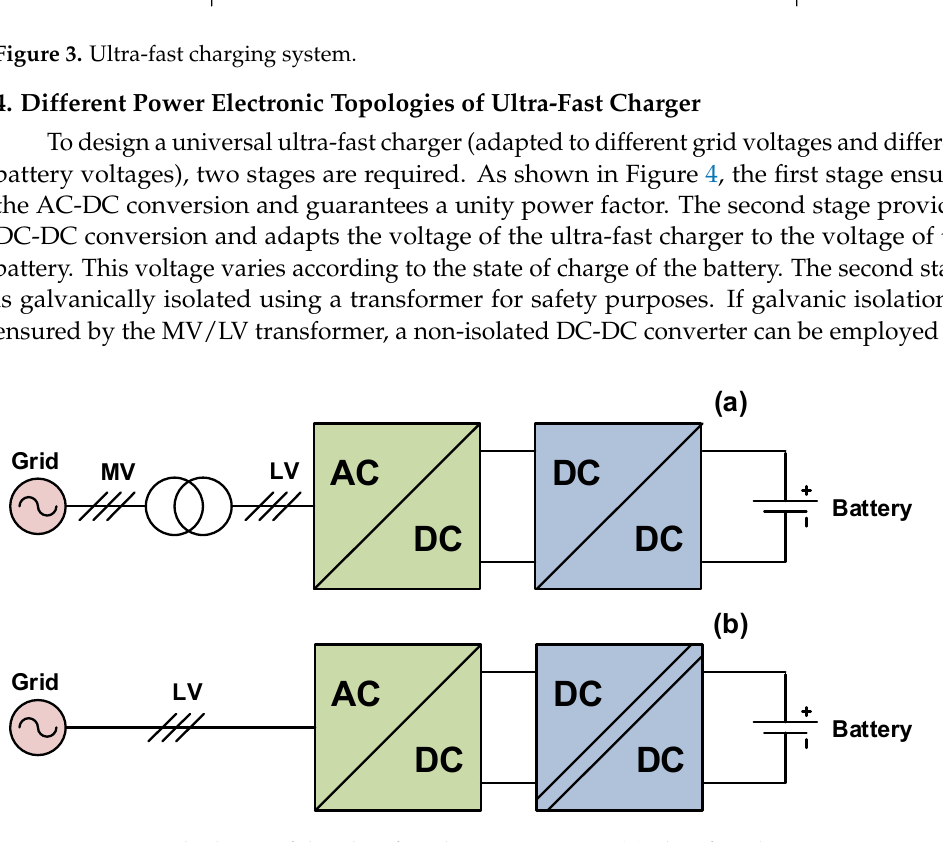
Figure 4. Structural scheme of the ultra-fast charging systems: ( a ) ultra-fast charging station with a non-isolated DC/DC converter; ( b ) ultra-fast charging station with an isolated DC/DC converter. 4.1. AC-DC Power Converters At the AC-DC stage, the three-phase two-level rectifier, NPC converter, and Vienna rectifier are widely used for off-board ultra-fast charging [29]. They are well-developed converters, the characteristics of which are suitable for the electric vehicle charging indus- try. As shown in Figure 5a, the three-phase two-level rectifier (3θ-2L) consists of six con- trolled switches. This power converter generates low total harmonic current distortion, provides bidirectional power flow, and achieves a power factor close to unity, with good efficiency and easy control [11]. However, a bulky filter inductor is required in this recti- fier compared to the other three-level topologies to regulate THD i to low values [30].